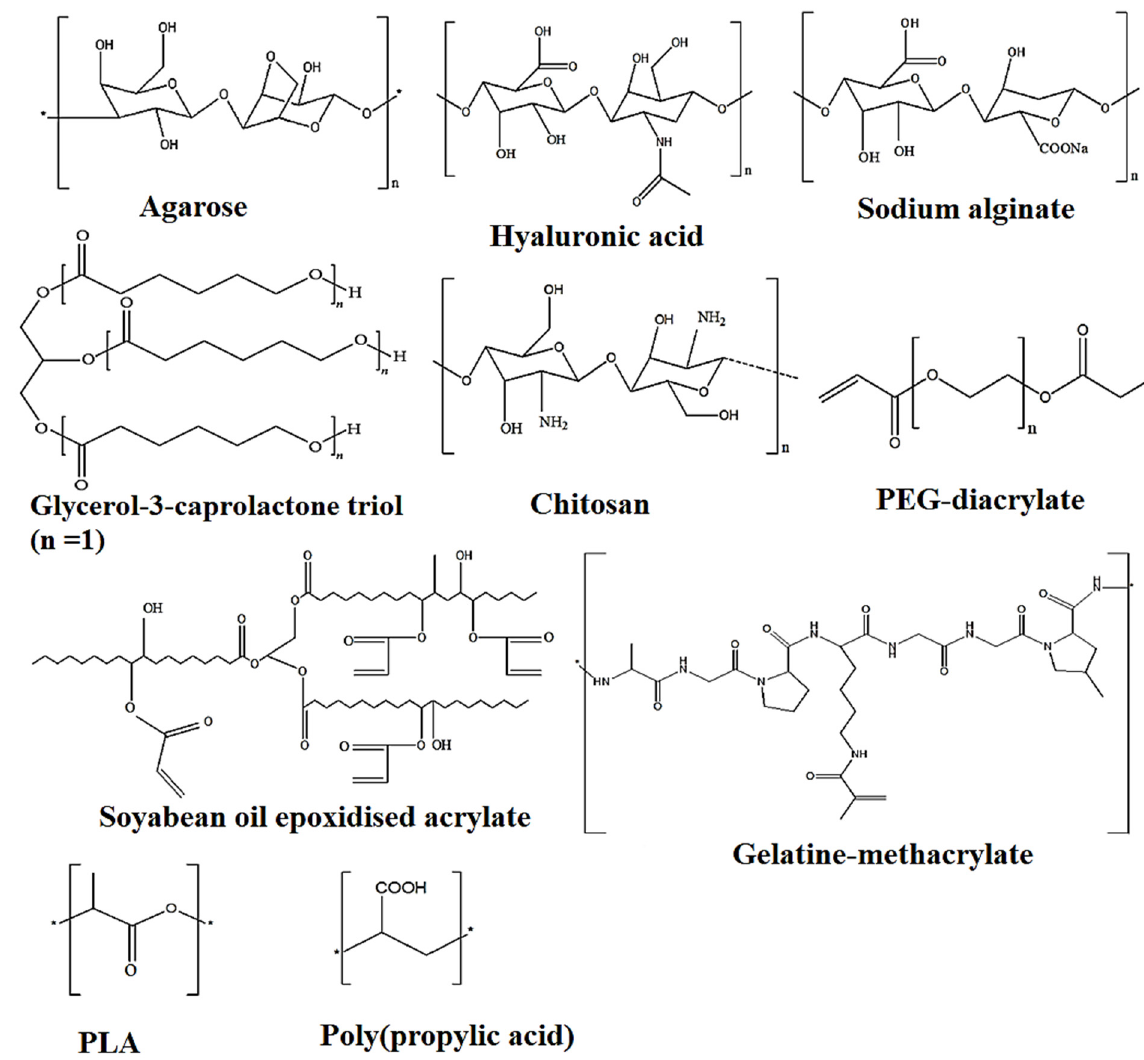
Figure 6. Chemical structures of a few biocompatible biopolymers executing 4D shape-morphing behavior in response to stimuli.